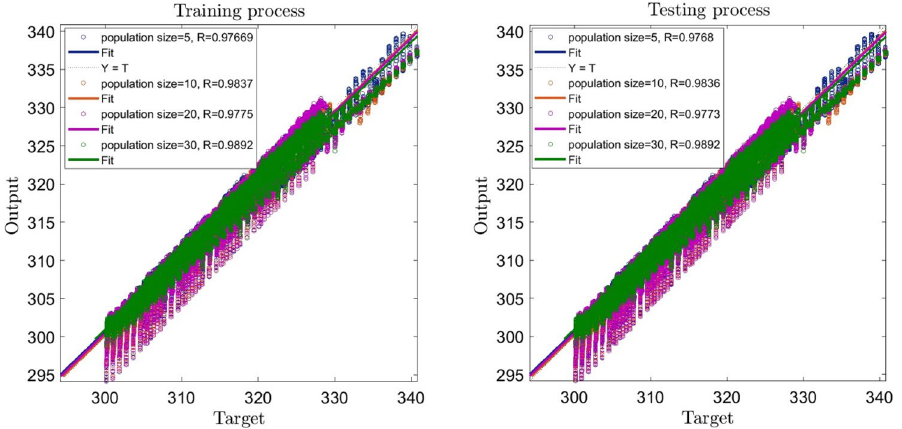
Figure 6. Learning process with changes in population size as GA parameter (5,10,20,30).